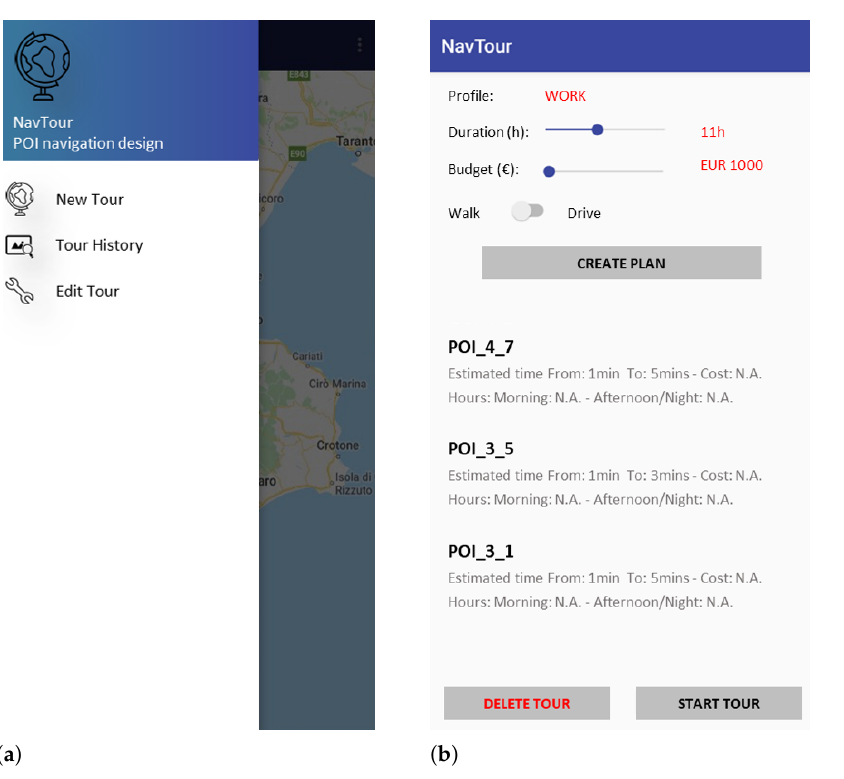
Figure 4. The NavTour Android application. ( a ) New itinerary; ( b ) Planned